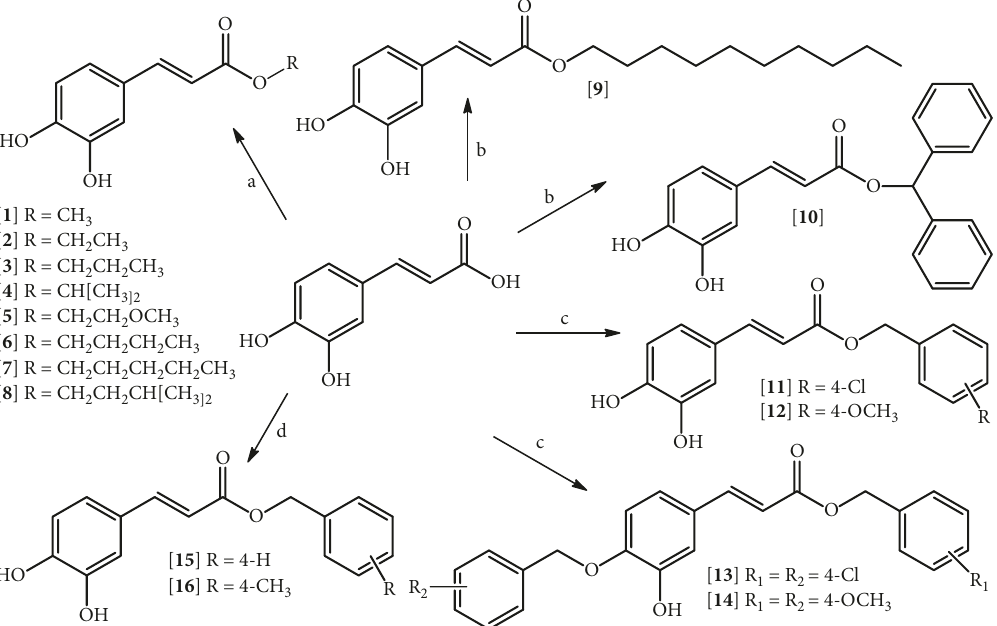
Scheme 1: Synthesis of the caffeic acid derivatives: (a) ROH, H 2 SO 4 , reflux; (b) Et 3 N, RX, acetone, reflux; (c) DMF, K 2 CO 3 , RX, room temperature; (d) ROH, THF, TPP, DIAD, 0 ° C to room